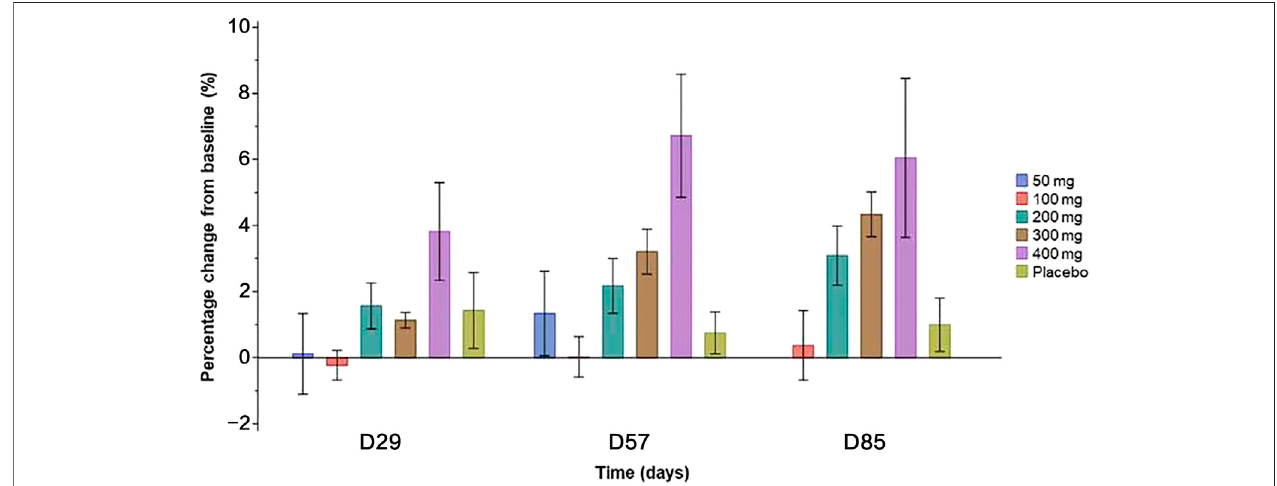
FIGURE 4 | The effect of SHR-1222 on bone mineral density at lumbar spine L1-L4.